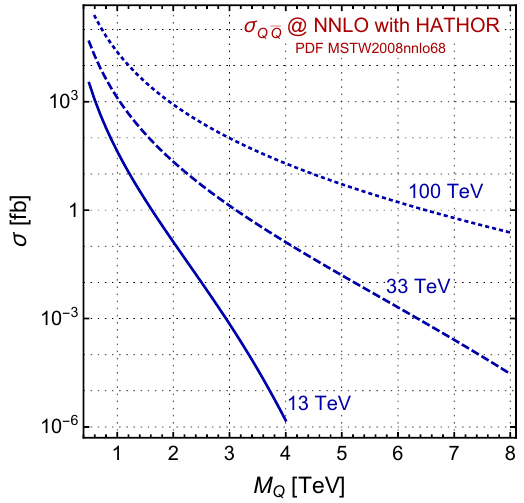
Figure 6 . Cross-sections for QCD induced heavy quark pair production at proton-proton colliders with di(cid:11)erent centre of mass